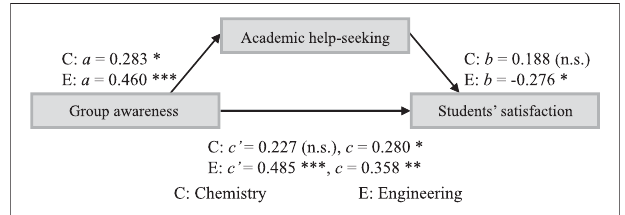
FIGURE 3 | Mediation model of the relationship between group awareness and student ’ s satisfaction via academic